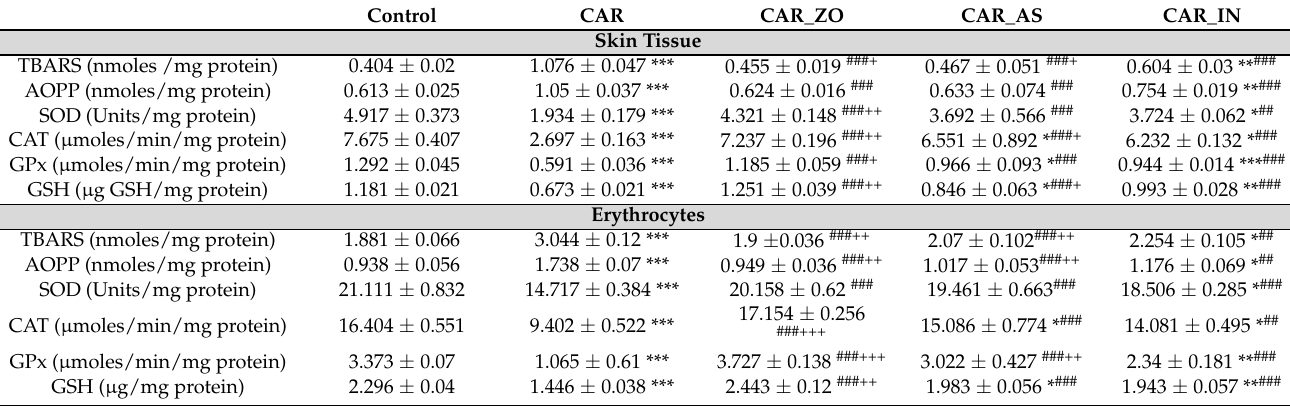
Table 3. Evaluation of oxidative and antioxidant statutes in skin tissue and erythrocytes: control rats, inflamed rats with CAR (CAR), inflamed rats and treated with ZO (CAR_ZO), inflamed rats treated with AS (CAR_AS) and inflamed rats treated with indomethacin